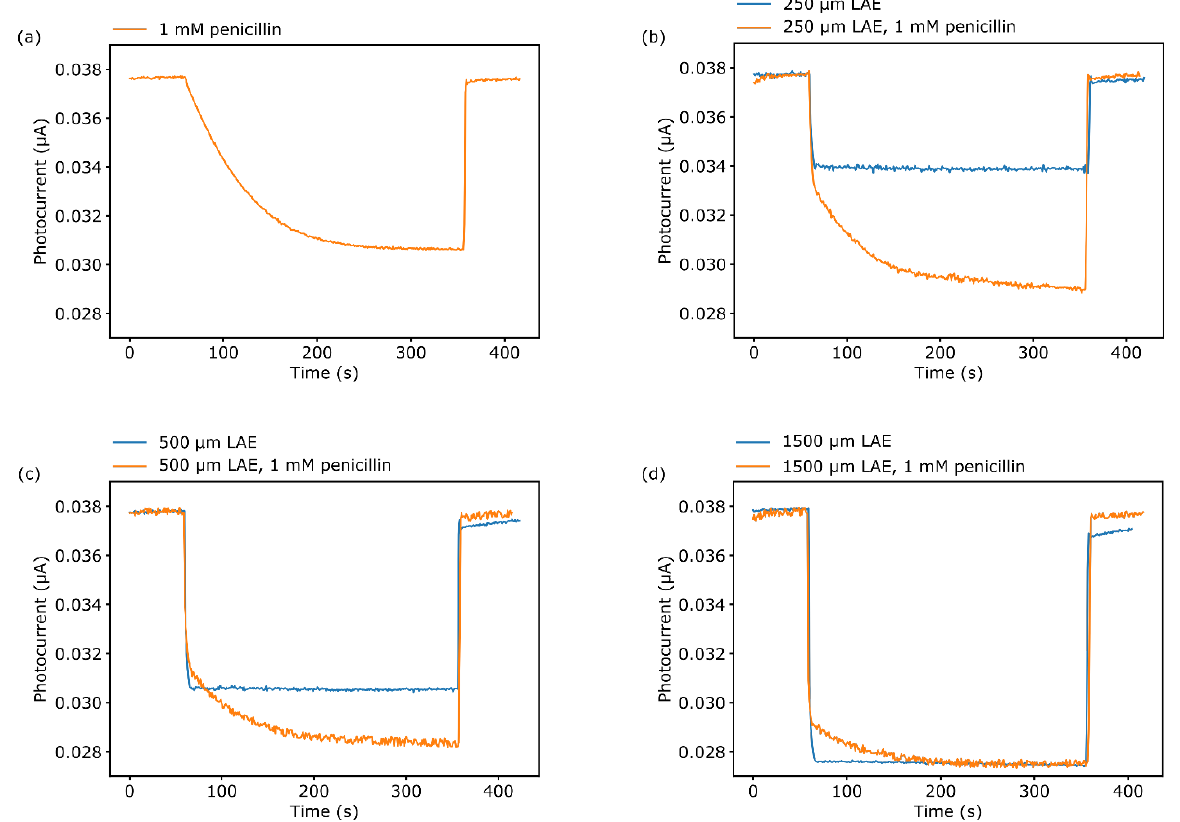
Figure 6. Constant potential LAPS measurements. ( a ) Photocurrent response for 1.0 mM penicillin in PBS buffer, pH 7.1. In ( b – d ) the blue curves depict the transient photocurrent decrease due to pH changes induced by the LAE with an illumination width of 250 µm, 500 µm and 1500 µm, respectively. The orange curves show the concatenated, additional change in photocurrent when 1.0 mM penicillin is added to the PBS buffer.